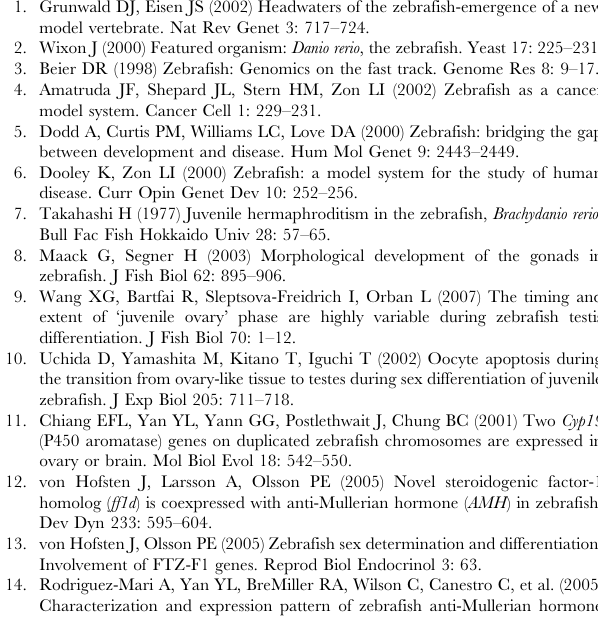
Table S9 List of 93 gonad-expressed genes that show male brain-enhanced expression. These genes i)show at least 1.5-fold